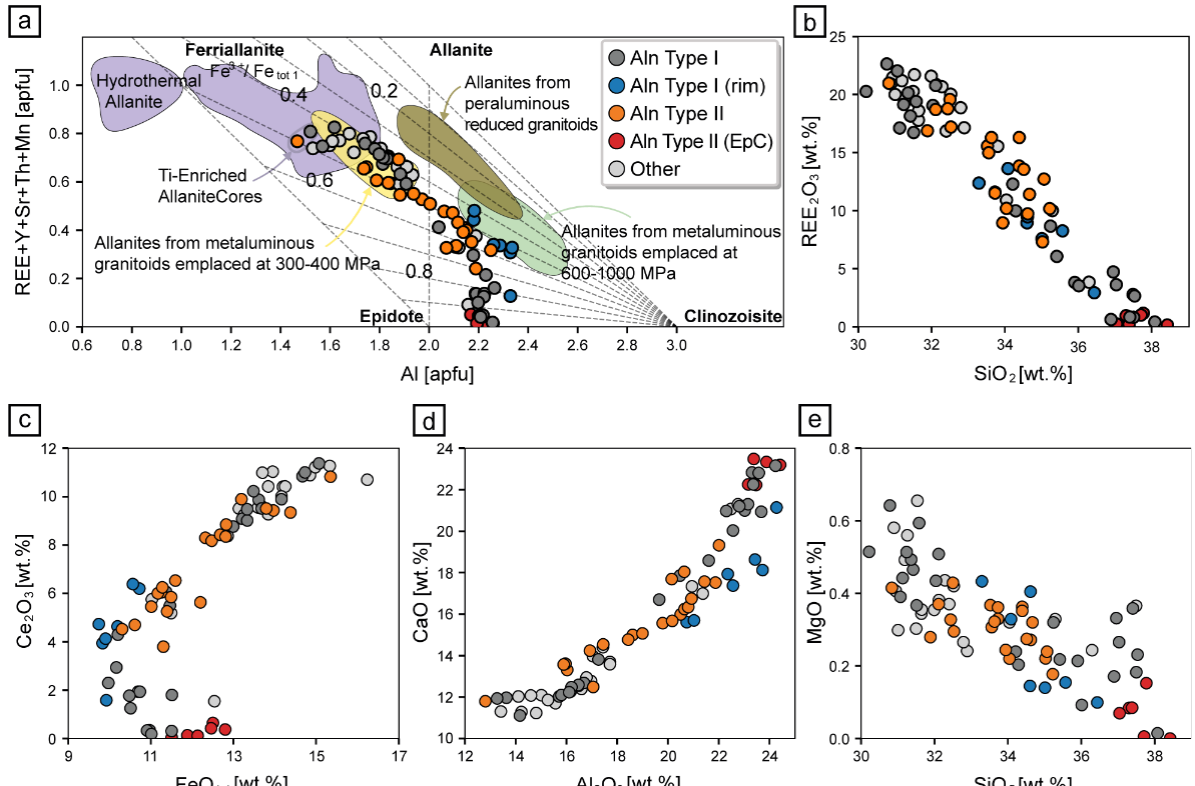
Figure 4. ( a ) Cationic Al vs. REE plot after Petrík et al. [46], showing the position of the studied allanites in the ferriallanite ‐ allanite ‐ epidote ‐ clinozoisite system. ( b ) SiO 2 vs. REE 2 O 3 (sum of rare earth element oxides. ( c ) FeO tot (total Fe oxides) vs. Ce 2 O 3 . ( d ) Al 2 O 3 vs. CaO. ( e ) SiO 2 vs. MgO. Aln Type I: Allanite Type I. Aln Type II: Allanite Type II. EpC: Epidote corona. Yellow, green and brown areas: allanite from peraluminous and metaluminous Variscan granitoids [47]. Purple area: hydro ‐ thermal allanite [48,49].